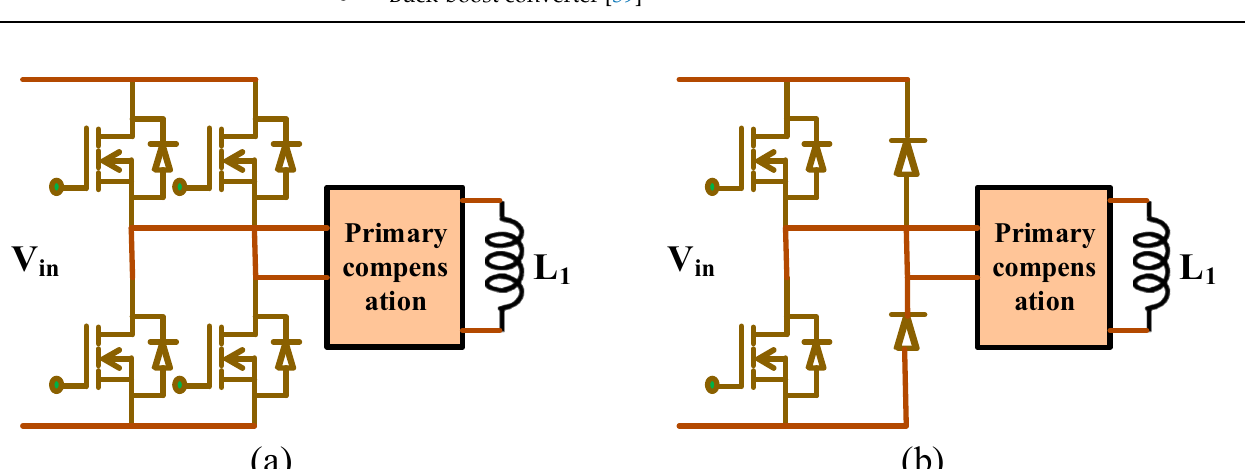
Figure 5. Static WPT high-frequency converter topologies: ( a ) full bridge type and ( b ) half bridge type.